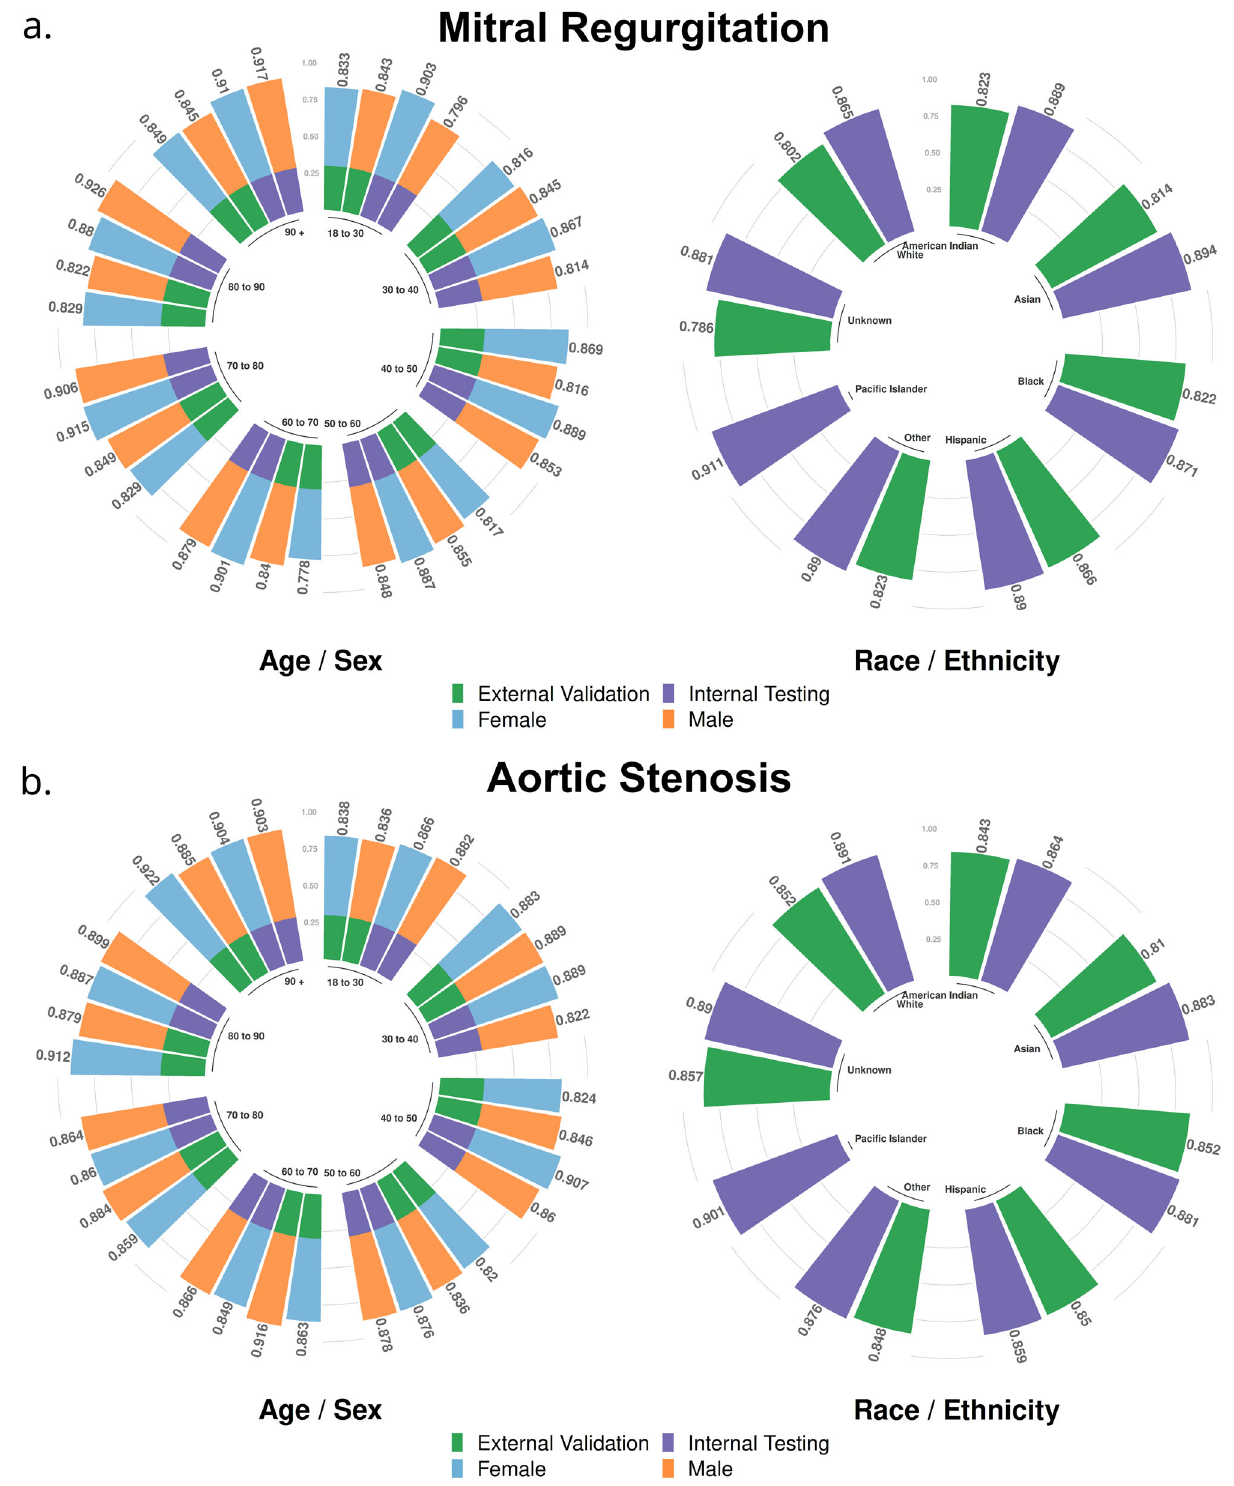
Fig. 3 Model performance by age, sex, and race subgroups. Panel a Mitral Regurgitation. Panel b Aortic Stenosis. Values presented are Area Under Receiver Operating Characteristic Curve (AUROC). Bar segments at bottom delineate internal testing and external validation by color. Inner circles represent groups by age/US Census de fi ned racial categories. Source data for fi gure is available in Supplementary Data 1 –